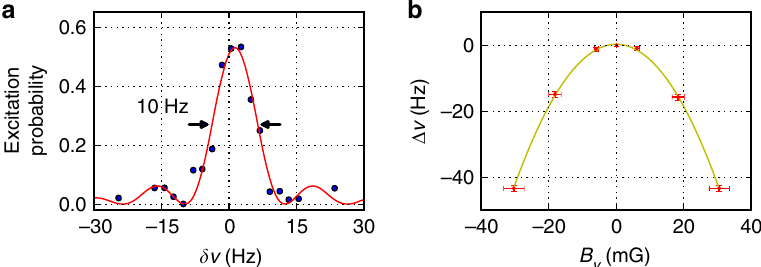
Fig. 3 Spectroscopy of the clock transition. a Spectral line shape of the clock transition in Tm. Every point is an average of six measurements. The solid curve shows the fi t calculated for a Fourier-limited 80 ms rectangular π -pulse. δν is the detuning from an exact resonance. b Clock transition frequency shift Δ ν depending on B y (dots) at B z = 0 and constant B x = 225 mG; the solid line is a parabolic fi t. The dependence on B z is similar. Error bars represent 1 s.d. of the B y magnetic fi eld (horizontal) and of the measured frequency shift (vertical)